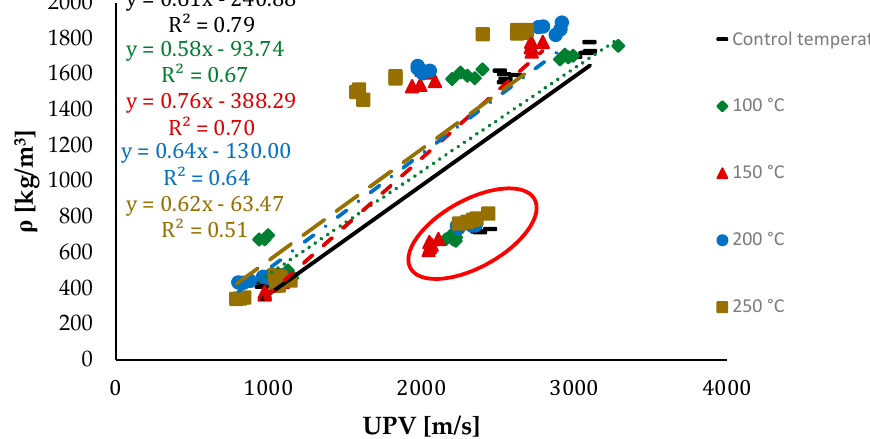
Figure 8. Relationship between ultrasound pulse velocity and bulk density.